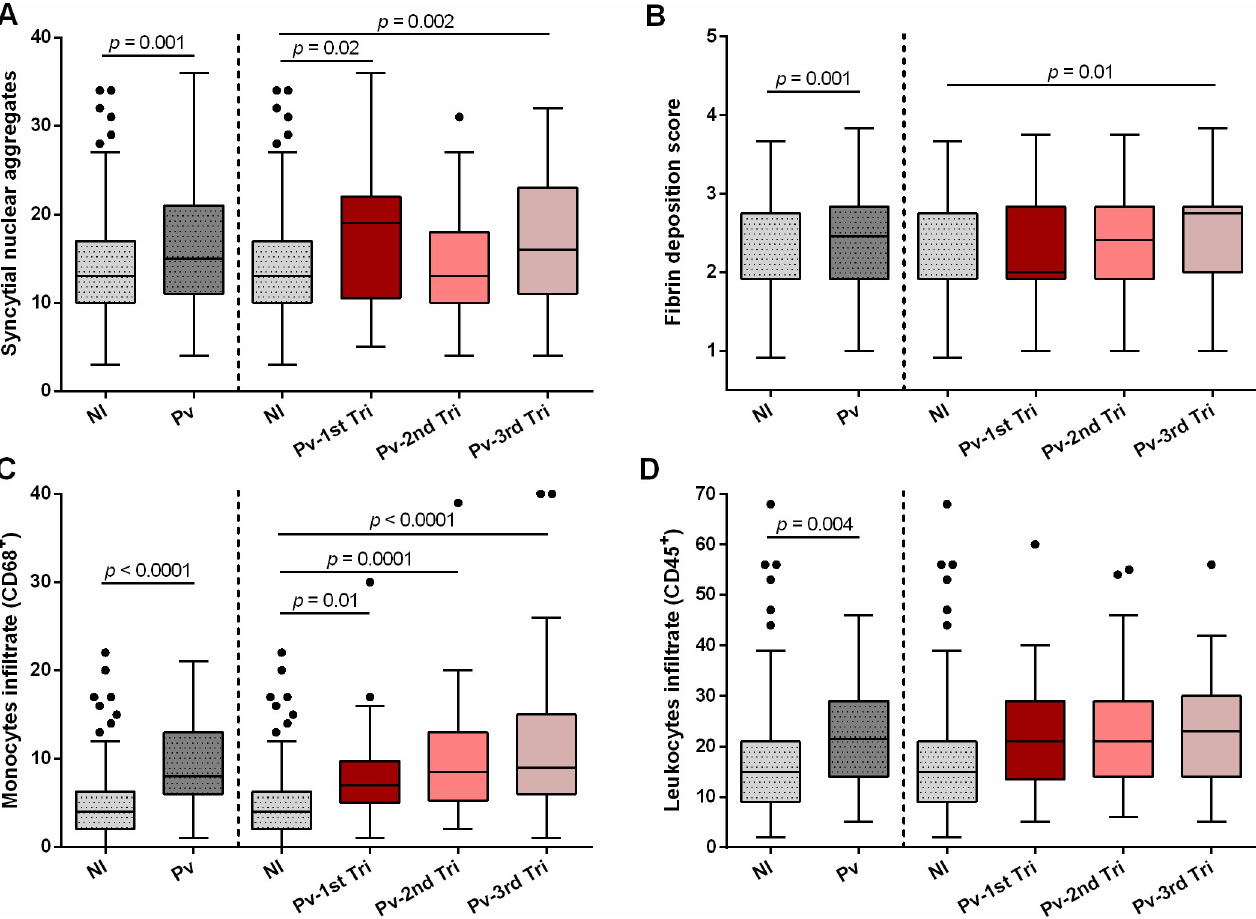
Fig 4. Evaluation of placental histological parameters according to maternal infection and trimester of first infection. (A) Syncytial nuclear aggregates; (B) Fibrin deposition score; (C) Monocytes infiltrate (CD68+); (D) Leukocytes infiltrate (CD45+). Histologic parameters were evaluated by microscopy through H&E (syncytial nuclear aggregates and fibrin deposition) or immunohistochemistry (monocytes and leukocytes). NI–non-infected (N = 153–155); Pv– P . vivax - infected pregnant women (N = 118–128); Pv-1 st tri– P . vivax infection 1 st trimester (N = 33–37); Pv-2 nd tri– P . vivax infection 2 nd trimester (N = 42–44); Pv-3 rd tri– P . vivax infection 3 rd trimester (N = 43–47). Data are represented as Tukey boxplots, with the bottom and top of each box representing the first and third quartiles; the line inside the box is the median, and the whiskers represent the lowest and the highest data within 1.5 IQR of the first and upper quartiles; and the circles, outliers. Differences between groups were determined by multiple liner regression (adjusted for maternal age, gravidity status, residence, education level, and occupation).